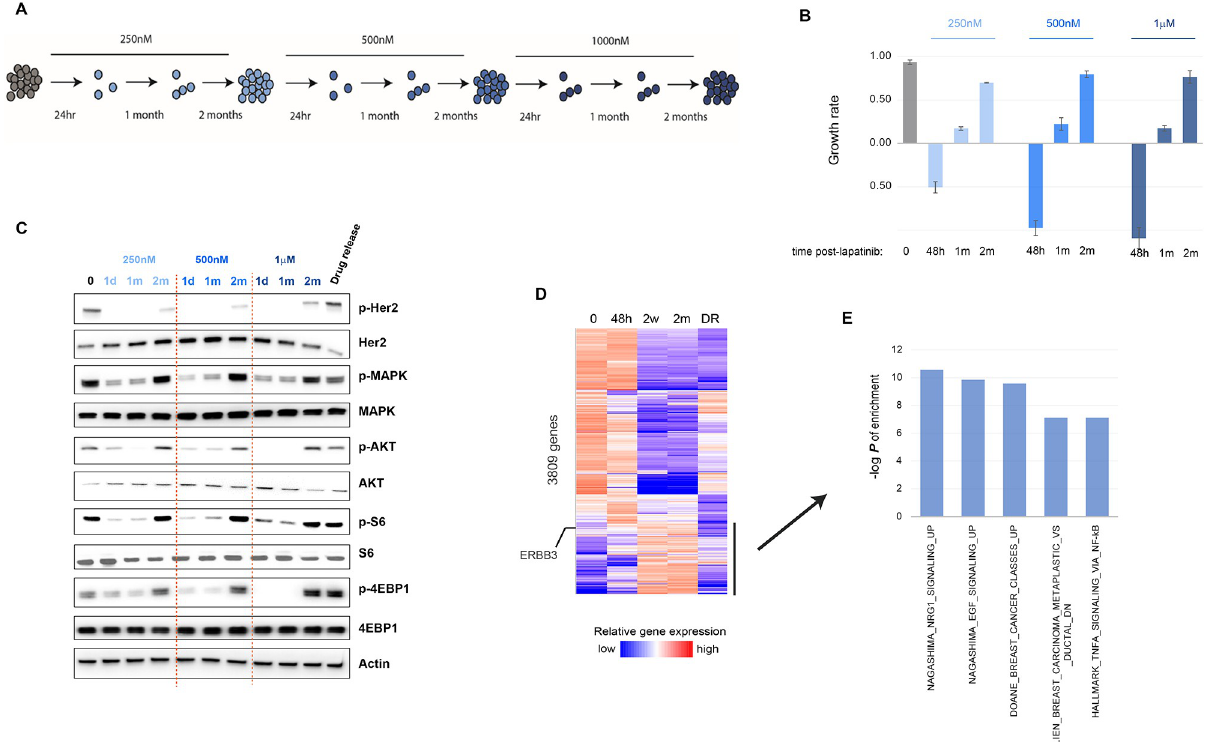
Fig 1. Developing a model of acquired resistance to anti-Her2 therapy in vitro . A) SKBR3 breast cancer cells were cultured in lapatinib till they gained resistance and started active growth under drug (typically * 2 months), when the lapatinib concentration was increased as shown. B) Growth rate (difference in relative viability between days 1 and 3 of seeding divided by 2, see Methods) at the various stages of chronic lapatinib treatment. C) Western blot of the indicated phospho- and total proteins for key mitogenic signaling pathways downstream of Her2 at the indicated time points after the start of lapatinib treatment. The “Drug release” time point indicates 48 hours after the removal of the drug from the media after the 2 months in lapatinib. D) Whole-transcriptome analyses of cells at the indicated stages of 1 μ M lapatinib treatment. Coloring reflects z-score of normalization across the conditions for each gene. The highlighted portion of the heatmap shows genes that are selectively upregulated at the resistance (2W: 2 weeks) and relapse (2M: 2 months) phases. E) The signatures that were most enriched for the highlighted genes in (D) based on GSEA analysis. Statistics: In (B), error bars show standard deviation of 3 replicates, and is representative of multiple ( > 2) independent experiments. Densitometric quantitation of the immunoblotting data are provided in S1